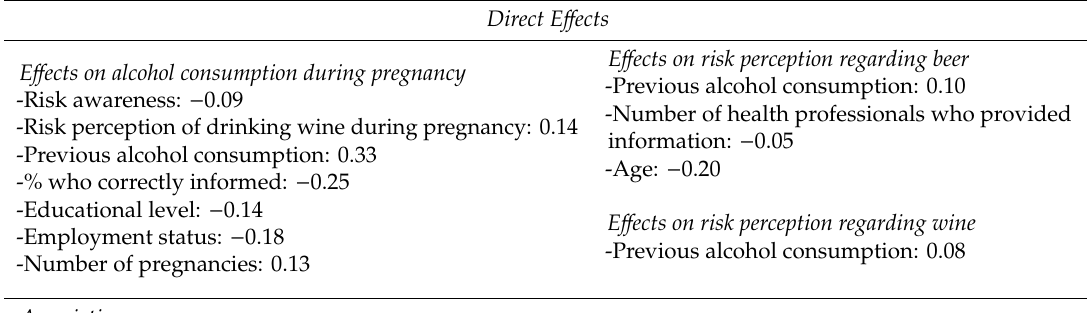
Table 4. Significant e ff ects and associations included in the structural equation